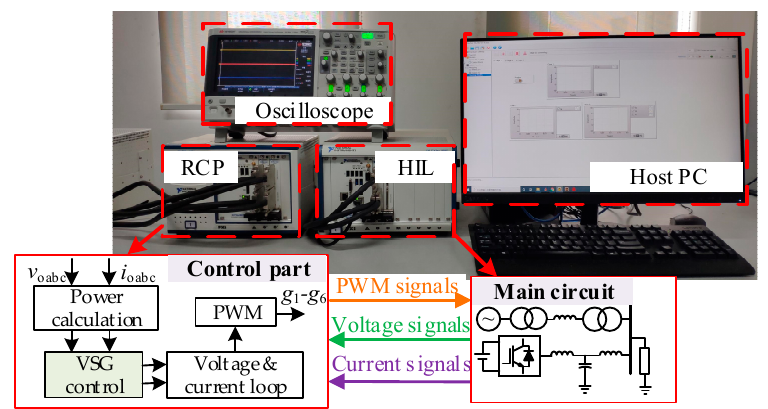
Figure 17. Photograph of the semi-physical experimental platform.